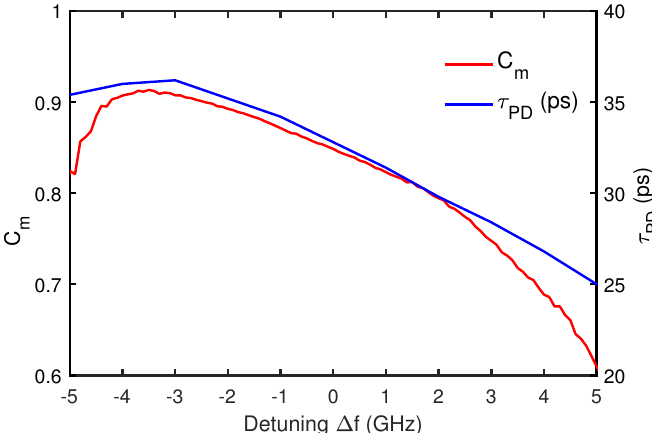
Figure 7. Transmitter-receiver maximum correlation coefficient C m (red trace) and the associated intra-cavity propagation delay τ PD (blue trace) as a function of frequency detuning for keeping η = 15 ns − 1 , κ = 9 ns − 1 , τ ext = 10 ns, and τ f = 0.